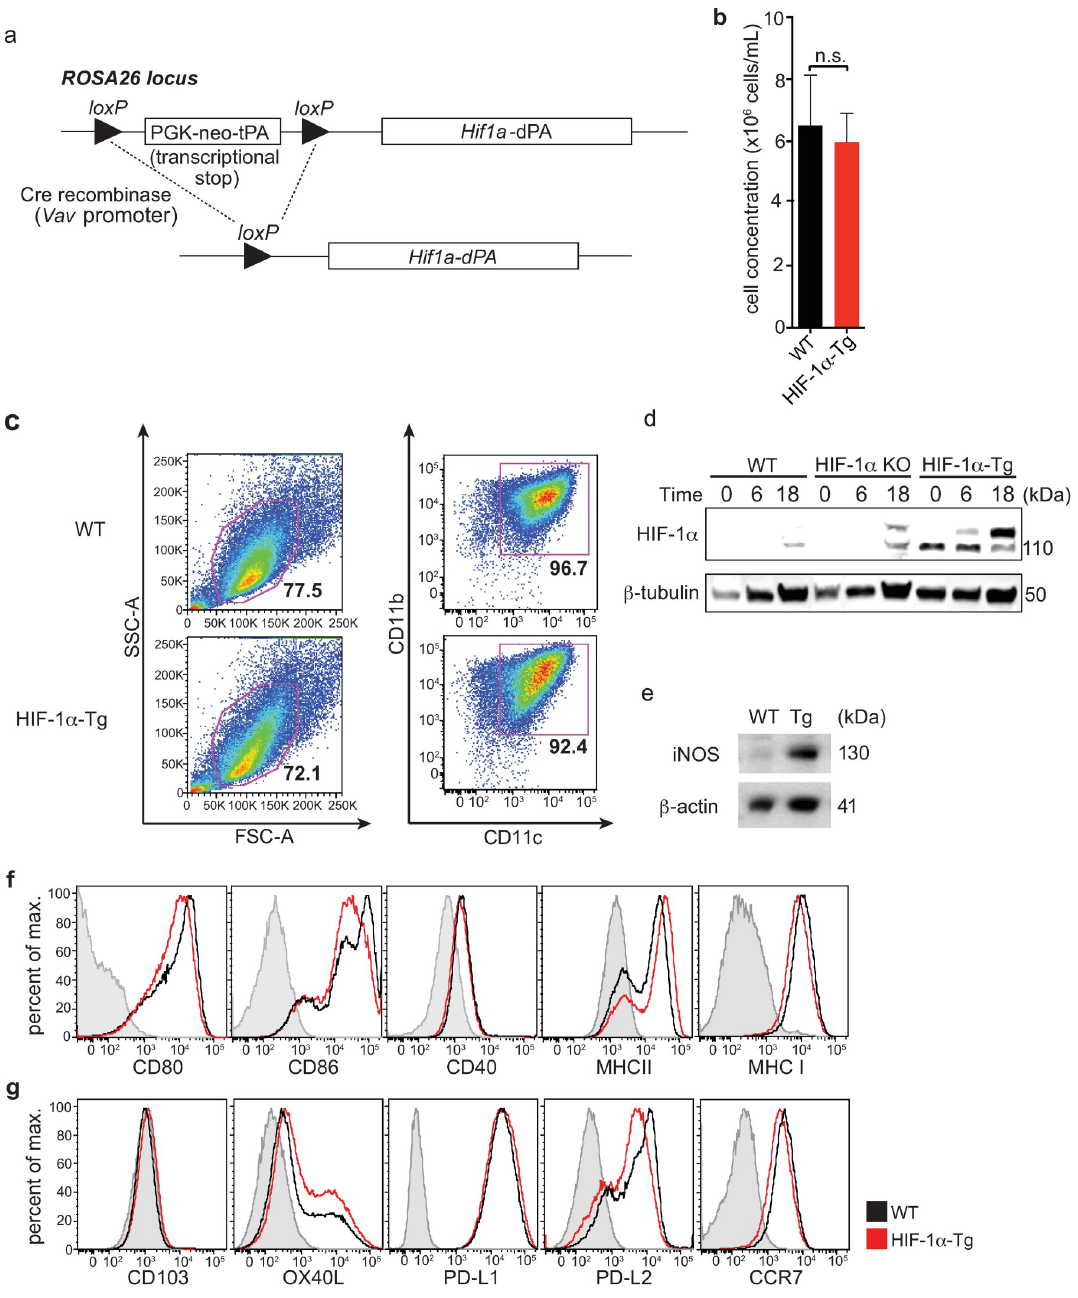
Fig 1. Constitutive expression of HIF-1 α in BMDCs leads to increased iNOS expression without affecting surface levels of co- stimulatory or co-inhibitory molecules. ( a ) Hif1 a-dPA loxP-stop-loxP mice express a transgene containing a floxed transcriptional stop cassette upstream of a mutated HIF-1 α with two proline to alanine substitutions (P402A and P564A; HIF-1 α -dPA). ( b ) Average cell concentration following 10 days of BM culture in the presence of GM-CSF (data shown is representative of 4 independent experiments). ( c ) BMDC frequencies, based on FSC/SSC and CD11c + CD11b + profiles, are similar between WT and HIF-1 α -Tg cultures. ( d ) Constitutive HIF-1 α expression was confirmed in HIF-1 α -Tg BMDCs by Western blot before or after stimulation with CpG for 16-20h. ( e ) Expression of iNOS (a direct HIF target) by Western blot in CpG-stimulated, WT and HIF-1 α -Tg BMDCs. ( f ) BMDCs were left unstimulated or stimulated with CpG, and stained for various DC activation markers and ( g ) other surface molecules including CD103, OX40L, PD-L1, PD-L2, and CCR7. For all plots, the solid black line indicates WT BMDCs and the solid red line indicates HIF-1 α -Tg BMDCs. FMO controls are indicated by the shaded grey histogram. For experiments with CpG stimulation of BMDC, stimulation was performed by adding CpG to BMDCs at a concentration of 10 μ M and incubating for 16-20h. Western blot data are representative of two independent experiments, and flow cytometry data are representative of at least five independent experiments. For ( b ), n.s.: not significant using Student’s t -test (two-tailed).